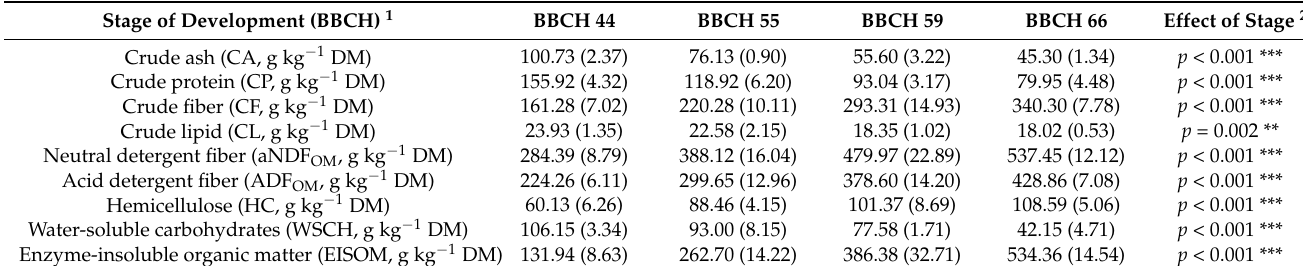
Table 3. Constituent characteristics of common ragwort ( J. vulgaris ) biomass depending on its averaged phenological stage. The means are presented with their standard deviations in brackets.